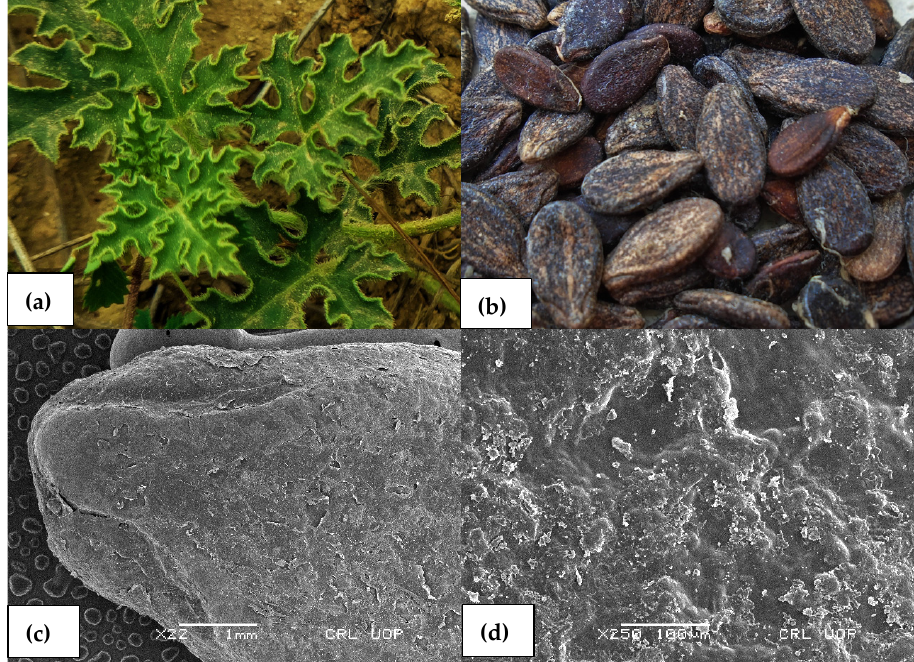
Figure 1. Cucumis melo var. agrestis ( a ) entire plant, ( b ) seeds, and ( c , d ) SEM micrographs of seed and sculpturing.